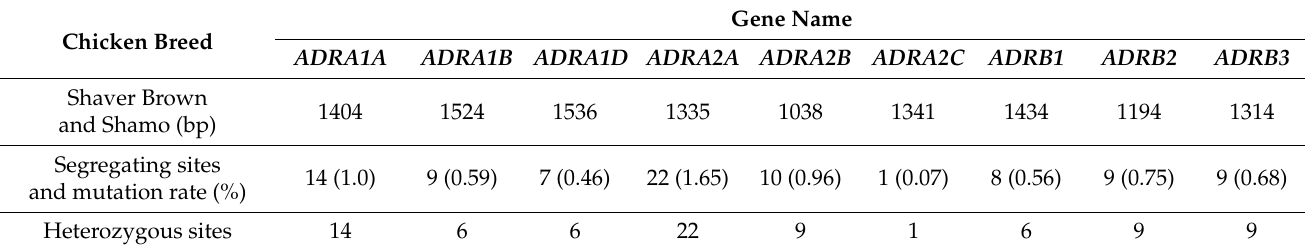
Table 4. The total number of base pairs sequenced for the nine adrenergic receptor (ADR) genes and their total segregating sites for the index of nucleotide differentiation ( N ST ) analysis.